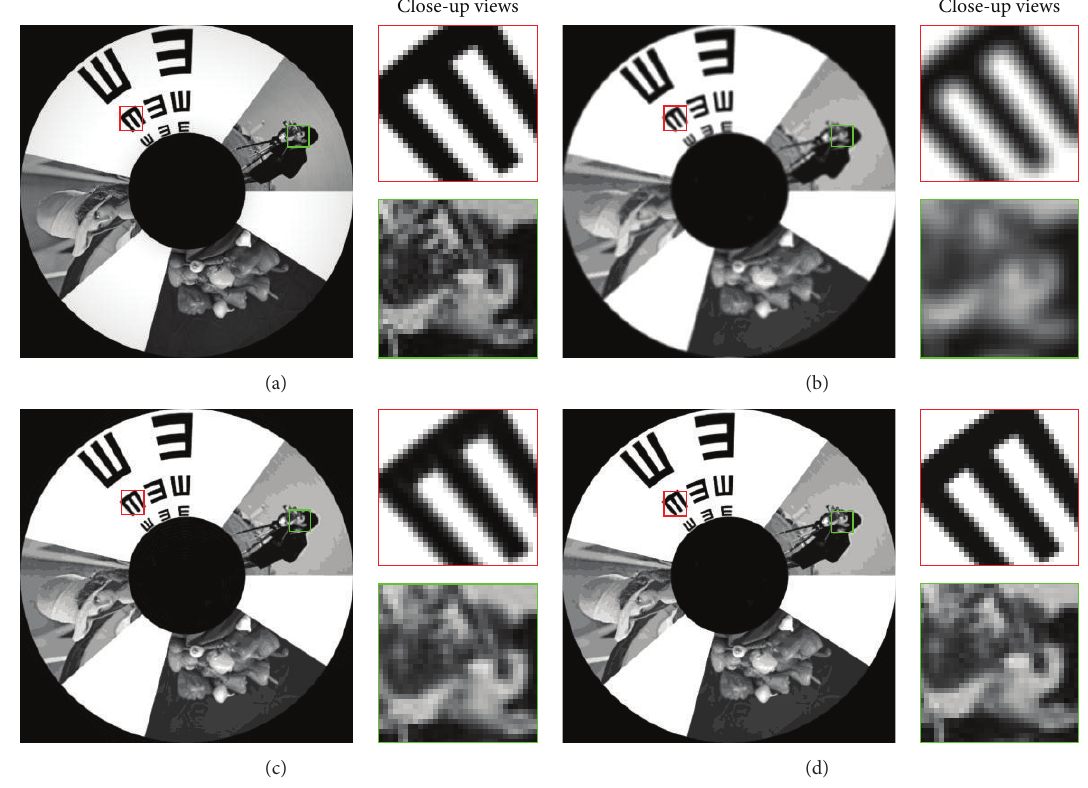
Figure 8: Defocus deblurring results of test image: (a) simulation omnidirectional image (ground truth); (b) blurry image; (c) deblurred results using TwIST algorithm, SNR = 22.87; (d) deblurred results using our proposed method (Omni-TV), SNR =